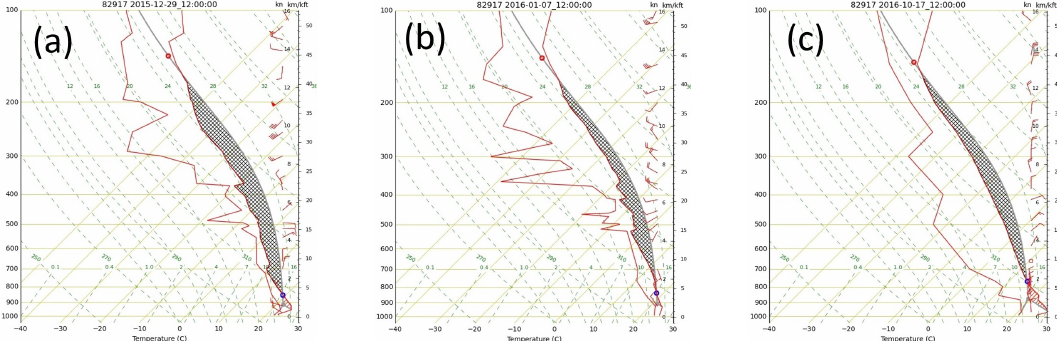
Figure 4. Spatial distribution of precipitation rate for the domain of 2 km (Figure 2d) from GPM data for ( a ) TS1 at 1830 LT; ( b ) TS2 at 1630 LT and ( c ) TS3 at 1630 LT. Longitudes, latitudes and contours of the Mantaro valley and Mantaro basin are indicated. The red circle indicates the position of the Huancayo observatory.